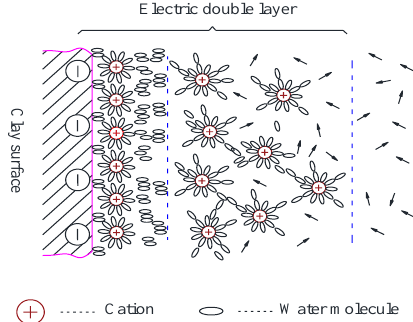
Figure 1. Schematic diagram of diffuse electric double layer.